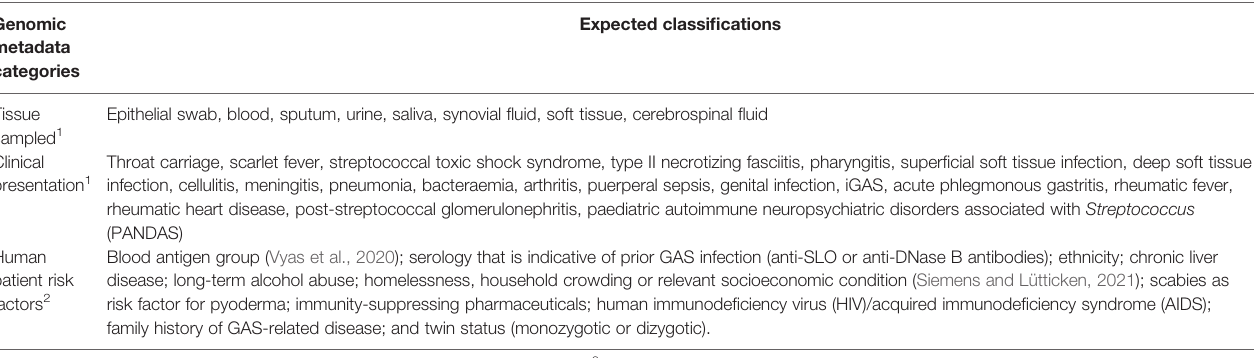
TABLE 1 | Compilation of the expected classi fi cations of tissues sampled, clinical presentation, and human patient risk factors in group A Streptococcus infection for use in a quality control protocol for the collation of high-quality virulence phenotype metadata.